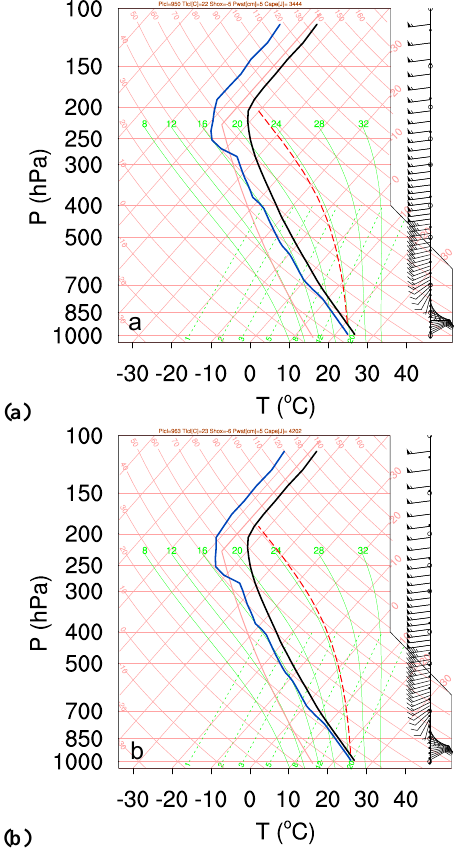
Fig. 1. Skew T -Log- P diagrams of the initial temperature and moisture data for the (a) lowRH and (b) highRH simulations. The soundings are adopted from Khain and Lynn (2009) with modifica-